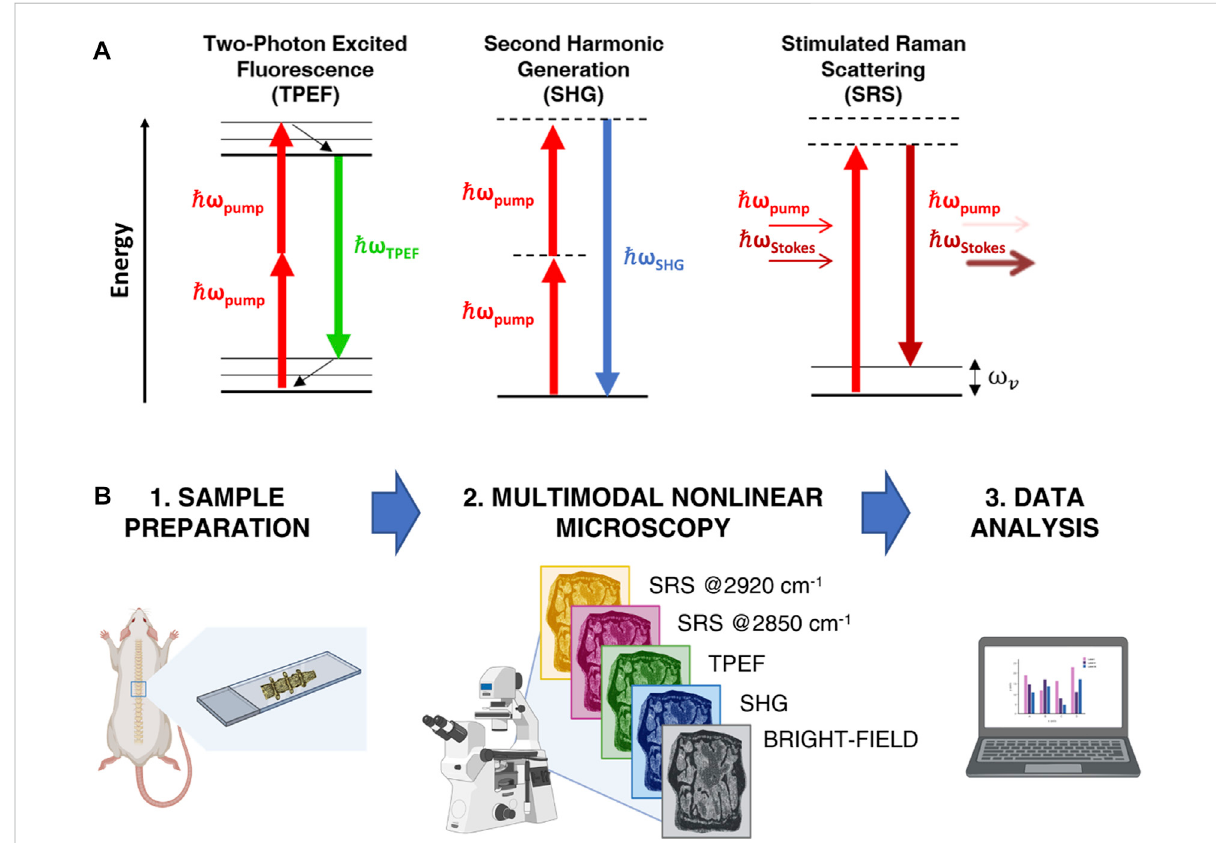
FIGURE 1 (A) Jablonski diagrams of TPEF, SHG and SRS processes. (B) Sketch of the experimental work fl